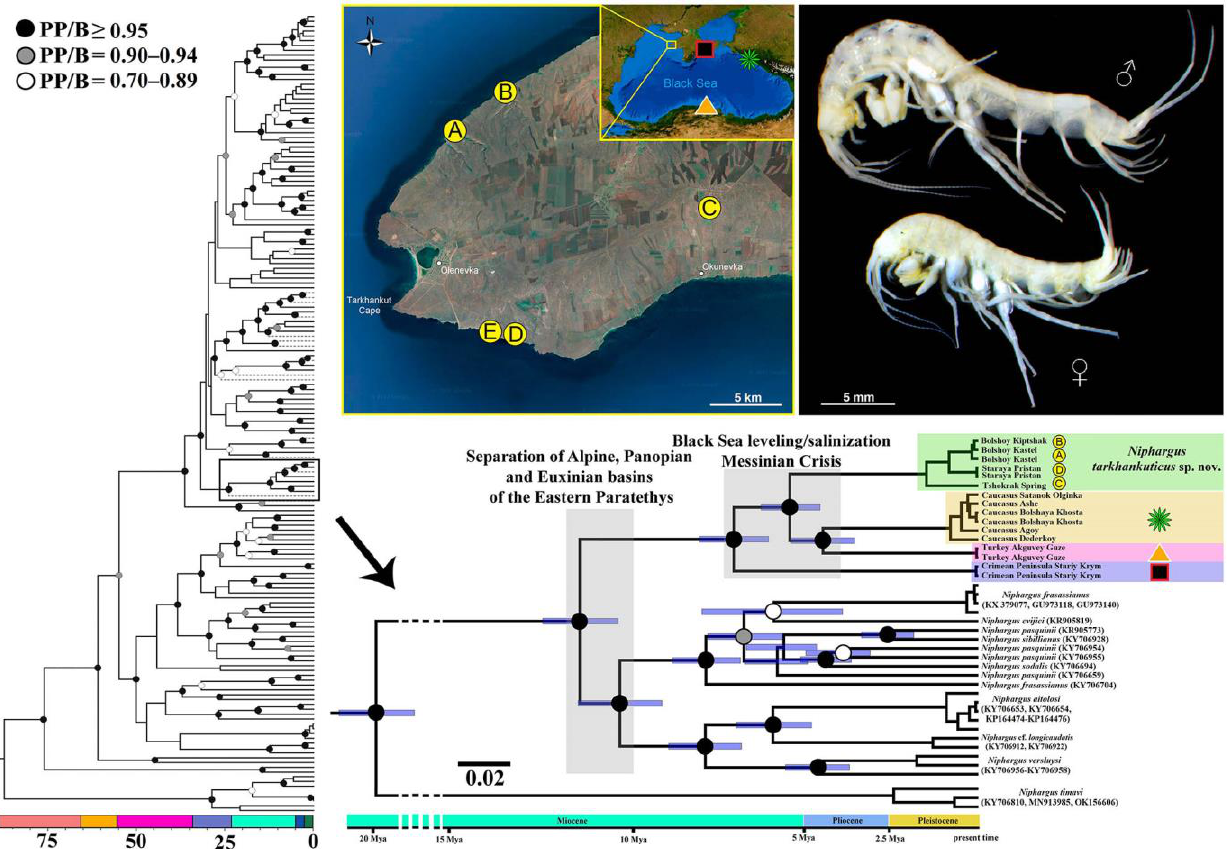
Figure 1. The map of collection sites and the time-calibrated phylogenetic tree (reconstruction) of phylogenetic relationships of the Niphargus tarkhankuticus sp. nov. from the Tarkhankut Upland, in the western part of the Crimean Peninsula. Sites are indicated as (A)—well in the Bolshoy Kastel Bay (type locality); (B)—well in the Bolshoy Kiptshak Bay; (C)—Tshokrak Spring 3.6 km north of the Okunevka; (D)—well in the Staraya Pristan (Ubezhishche) Bay; (E)—well near to the Tshashcha Lyubvi. Posterior probabilities of the nodes are reported. Blue horizontal bars show the 95% HPD (highest posterior density) of node ages on an arbitrary time scale. The general phylogenetic tree is taken from Copila¸s-Ciocianu et al. [19] with the adapted time-scale after McInerney et al.